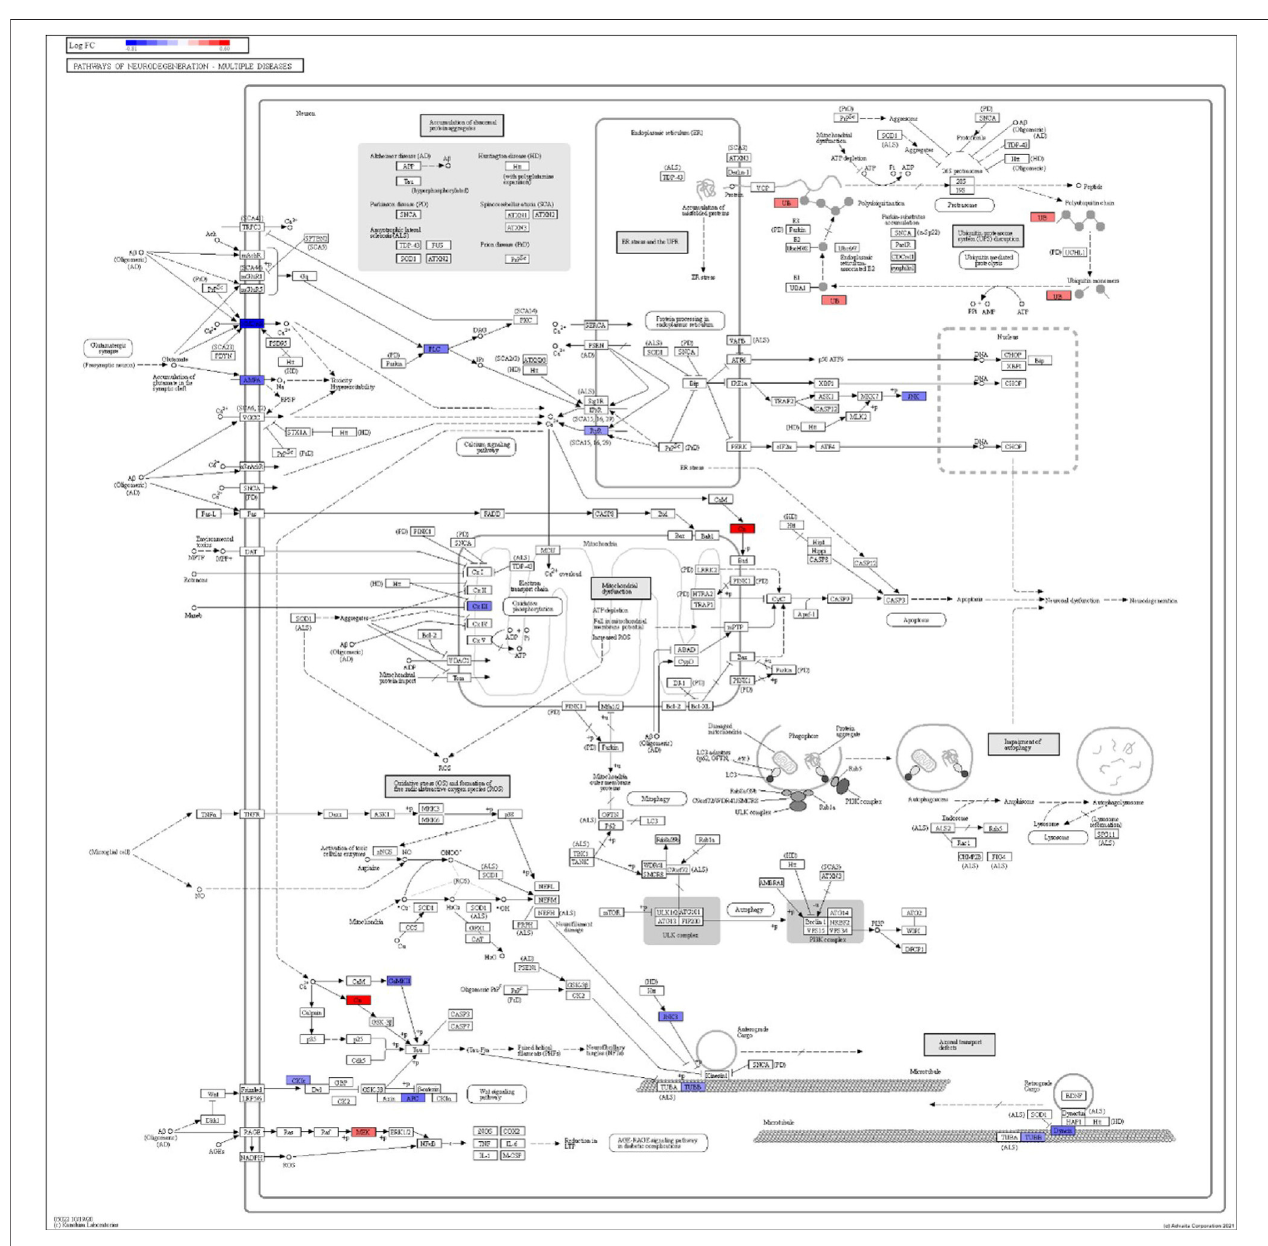
FIGURE 8 | iPathwayGuide analysis shows the differentially regulated genes in the KEGG neurodegeneration pathway (multiple diseases) in the astrocytes of the AD group (AD00206) compared to the astrocytes of the healthy control group (AD00201).